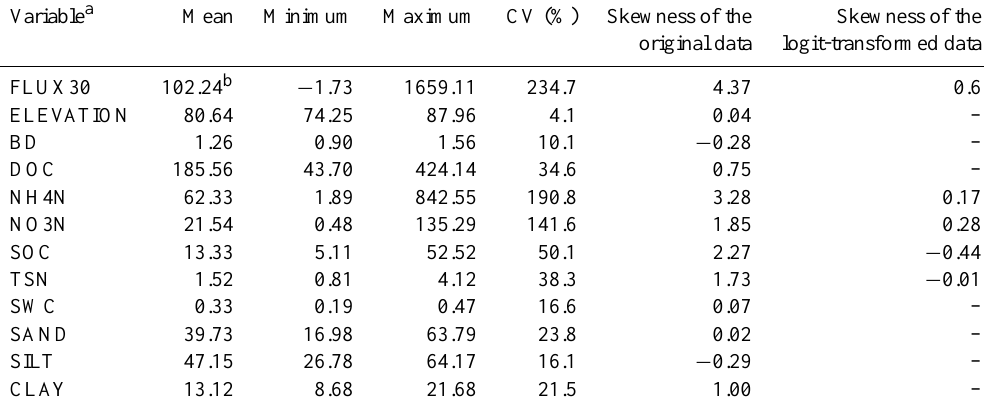
Table 1. Descriptive statistics of the N 2 O fluxes and environmental factors.